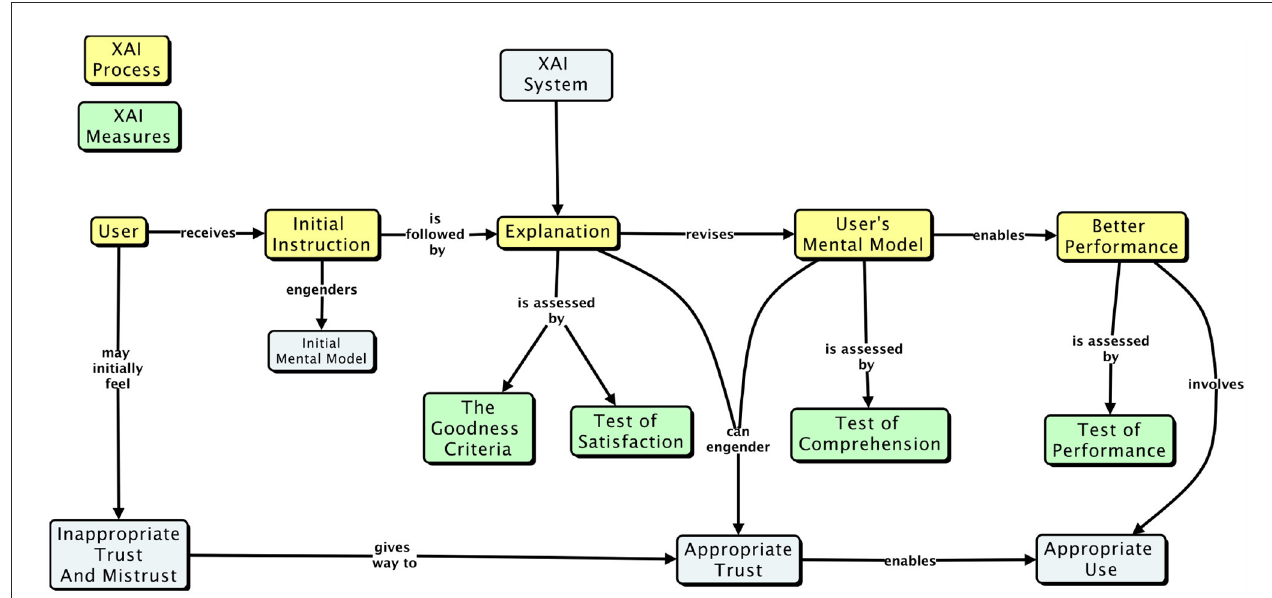
FIGURE1 A conceptual model of the process of explaining, in the context of evaluating XAI